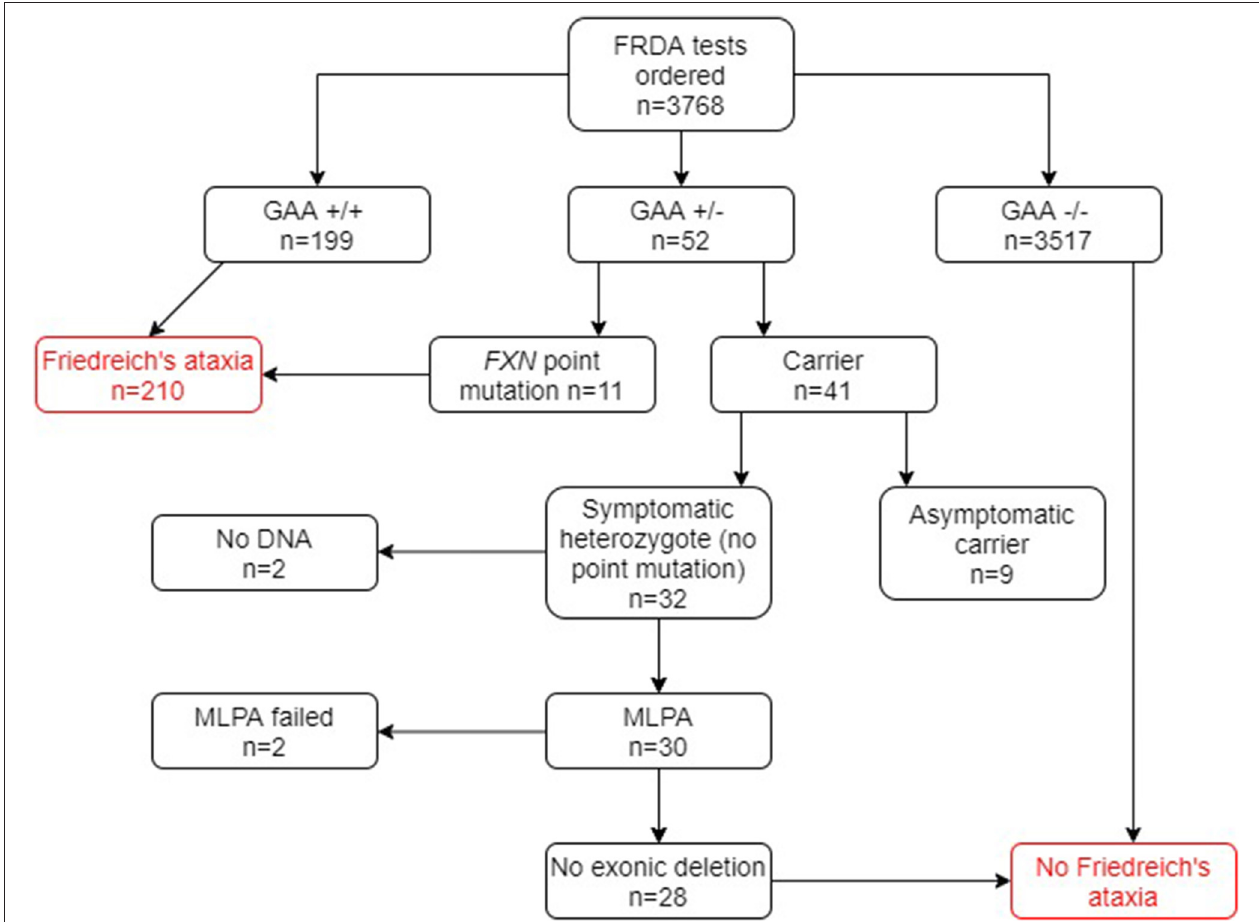
FIGURE 4 | Flowchart summary of genetic results in both groups A and B combined. GAA + / + two GAA expansions; GAA + / − one GAA expansion; GAA − / − no GAA expansions. MLPA, multiplex ligand-dependent probe amplification.